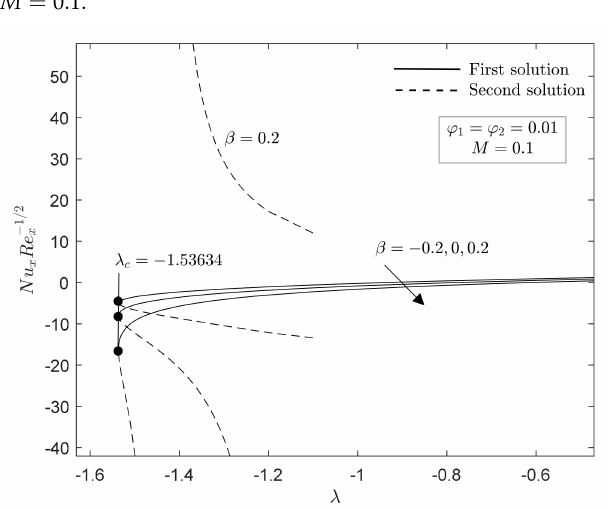
Figure 8. Local Nusselt number Nu x Re − 1/2 x with λ for some values of heat source/sink β when M =